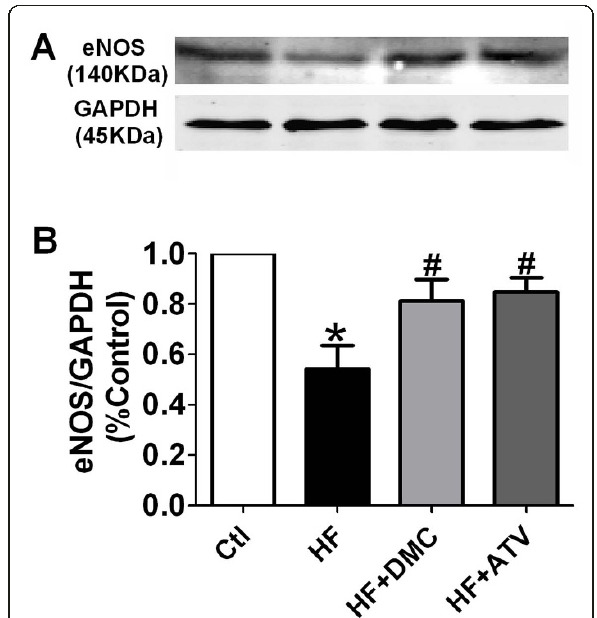
Figure 5 High-fat-induced attenuation of eNOS protein expression in thoracic aorta and mitigation by DMC and ATV . ( A ) Representative examples of western blot assay of eNOS (140 kDa) protein are shown including GADPH expression (45 kDa) as a loading control. ( B ) Statistical bar graph indicates the result of densitometric analysis of the bands as normalized to the quantity of GADPH protein. These ratios were normalized to control. * P < 0.01 vs. control group, # P < 0.05 vs. HF, n =